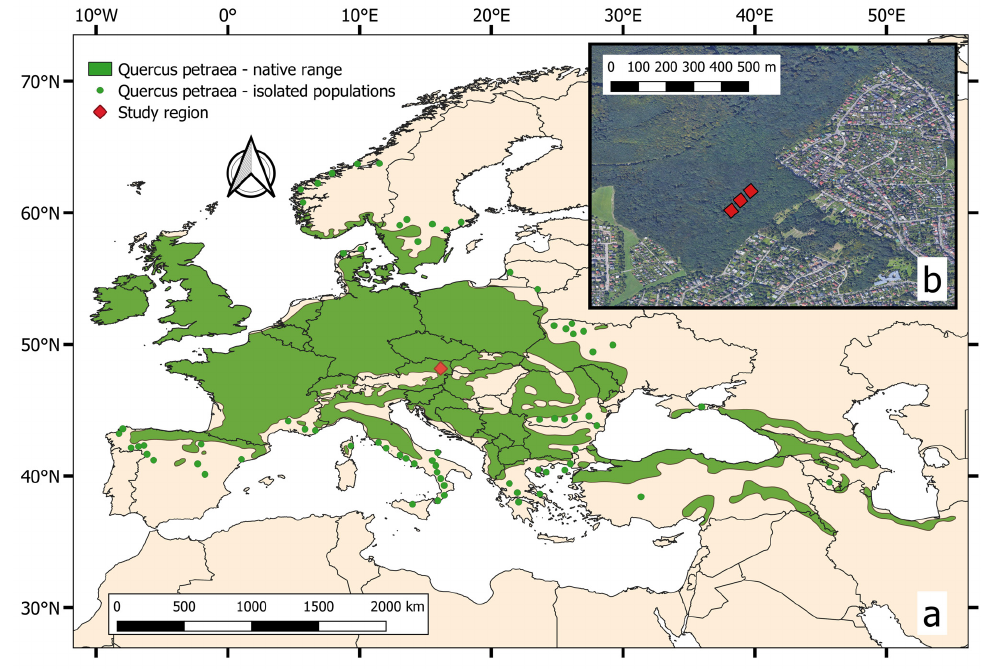
Figure 1. Current distribution of Quercus petraea, sessile oak [30] in Europe ( a ) and enlarged location of study area and the three sample plots ( b ). Three plots were studied with a size between 0.2 to 0.25 hectares. A larger plot size was favoured over replications, because the terrain is heterogeneous and replicating the plots would have compromised the comparability of the site conditions. Within the same area, a grid ‐ based forest inventory system (not used here) was established, using angle count sampling (‘Bitterlich sampling’) [31]. The elevation is about 300 m above sea level. The three plots are located within 20 m distance (about one tree length) along a foot ‐ path/skid trail used for harvesting (Figure 1b). Two plots were thinned in 2009 (chainsaw and skidding on the ground) and one plot was kept unthinned as control. The treatments were (1) moderate thinning (removal of ~50% basal area) and (2) heavy thinning (removal of ~70% basal area). The moderate thin ‐ ning was intended to induce more regeneration from seeds by more homogenous seed fall, in particular of Quercus spp. The thinning primarily targeted small ‐ middle sized trees up to about 30 cm DBH (mostly hornbeam) to promote growth of larger ‐ sized more valu ‐ able trees. The plots were measured three times, in 2009, 2014 and 2019. For each tree reaching breast height (1.3 m above ground), the diameter at breast height (DBH), tree height, tree status (alive, standing dead, harvested), and species was determined.